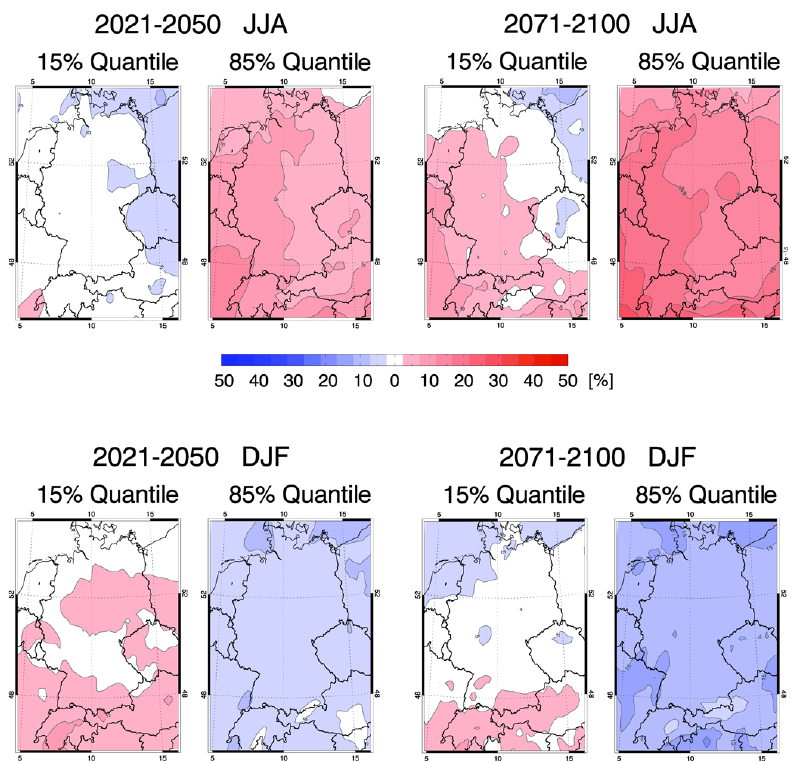
Figure 3. Projected relative change [%] of mean summer precipitation (JJA, upper figure), and mean winter precipitation (DJF, below); periods 2021–2050 (left), 2071–2100 (right), with respect to the control run 1961–1990 based on a 19 member ensemble of regional climate projections (see Table 1). Blue colours indicate increasing precipitation, red colours decreasing